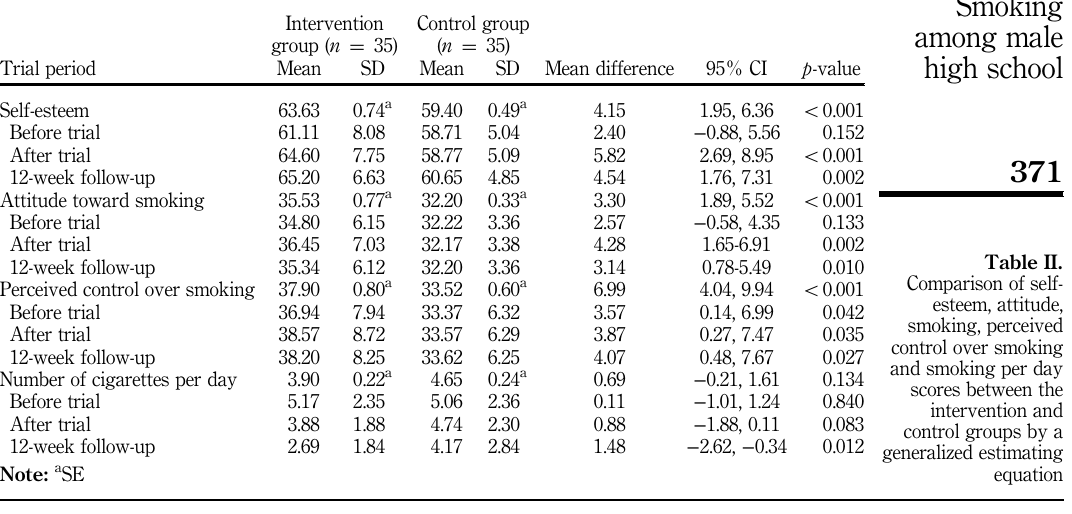
Table II. Comparison of self-